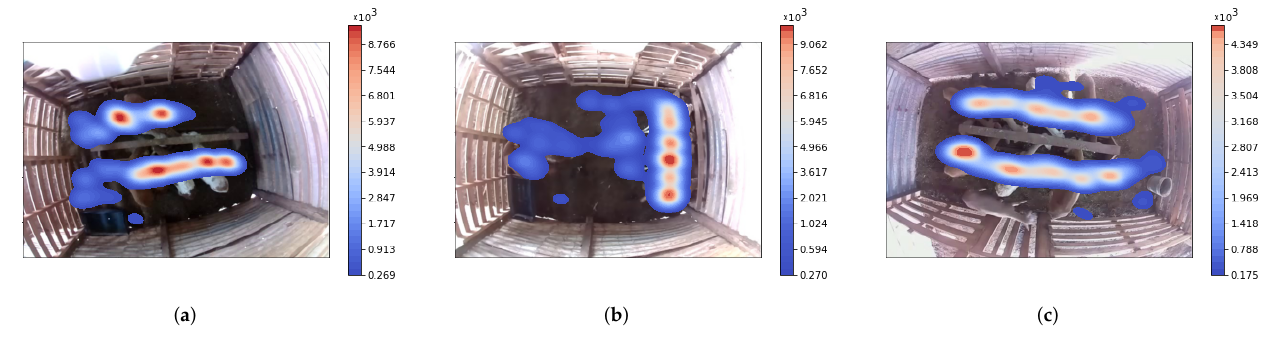
Figure 6. Heat maps samples of lambs location: ( a ) Barn 1—central distribution. ( b ) Barn 1—lateral distribution. ( c ) Barn 2—central